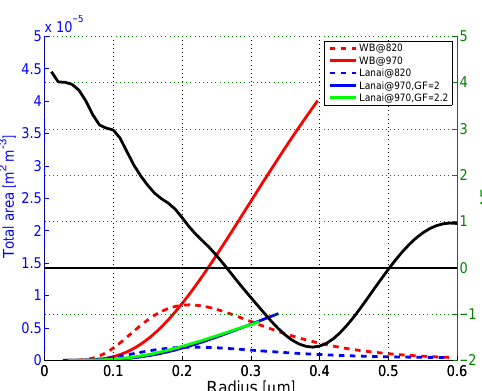
Figure 7. Total aerosol area per volume (LHS y axis) at different model levels, WB refers to Walker Branch, e.g., WB@820 means Walker Branch case and altitude of 820m. Lanai is shown for two growth factors, 2 and 2.2, as discussed in more details in the text. RHS y axis shows Ångström exponent, as a estimated for mono- disperse aerosol of given